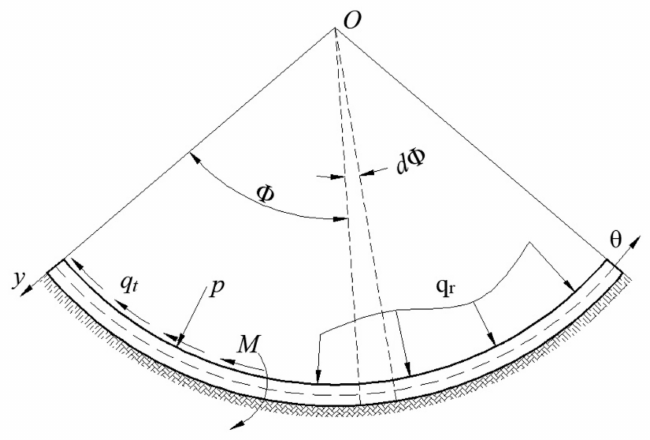
Figure 3. Schematic diagram of the circular curved beam on the Winkler elastic foundation